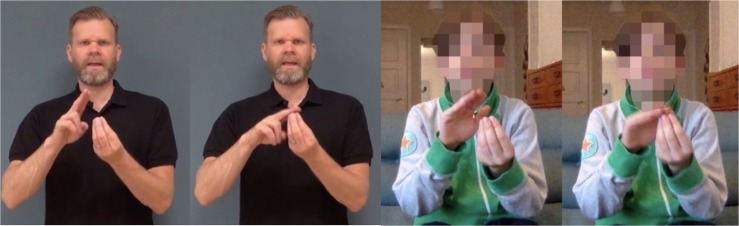
The first print screens from SignRepL2 represent the target sign for “ÄGG” [‘EGG’]. The second print screens represent a signing attempt of a participant who did not achieve full points because of incorrect hand shape and absence of mouth movement. Permission and written consents for using the print screens were obtained from the individuals and their parents, as well as the copyright holders of SignRepL2 (Schönström and Holmström, 2017).